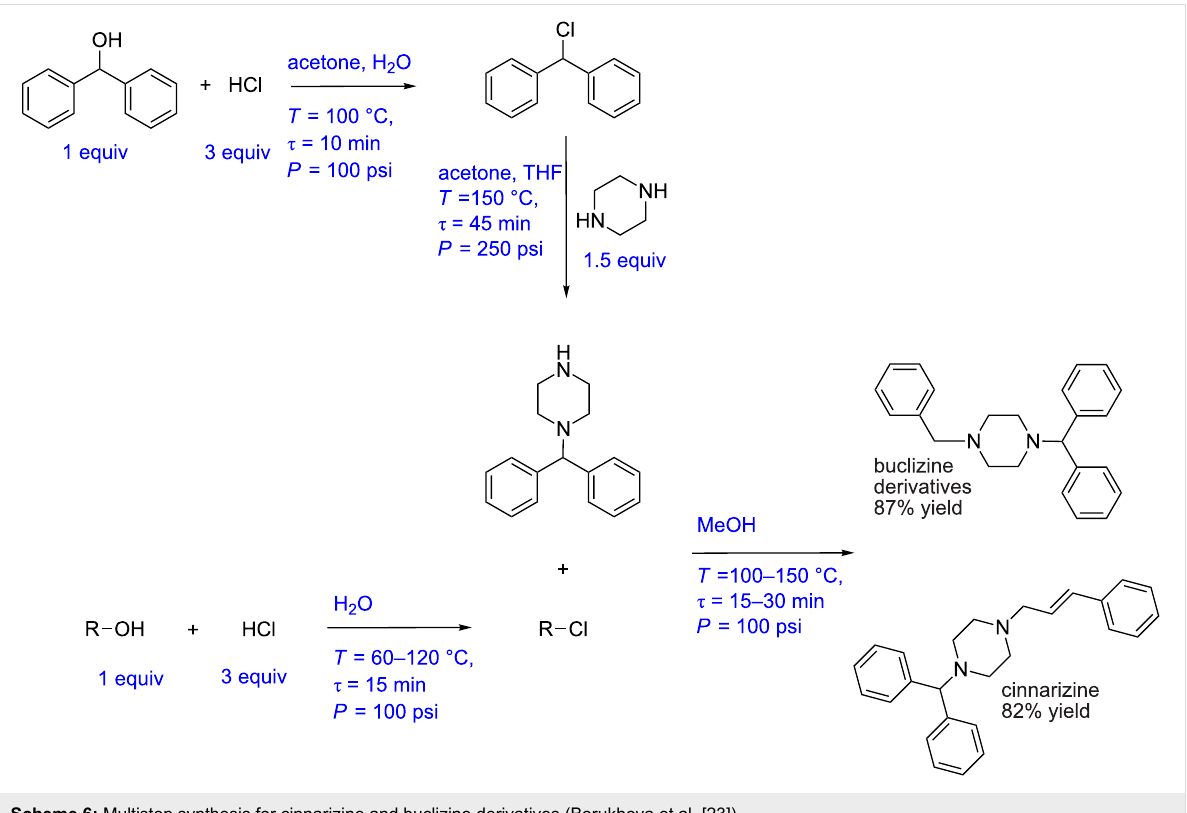
Scheme 6: Multistep synthesis for cinnarizine and buclizine derivatives (Borukhova et al.